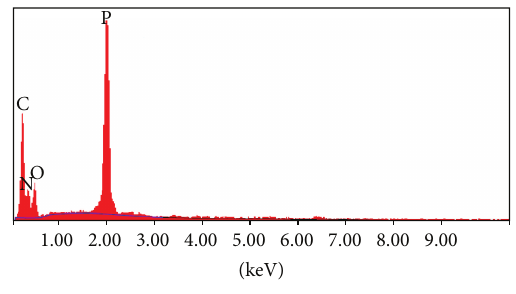
Figure 6: Elemental analysis of